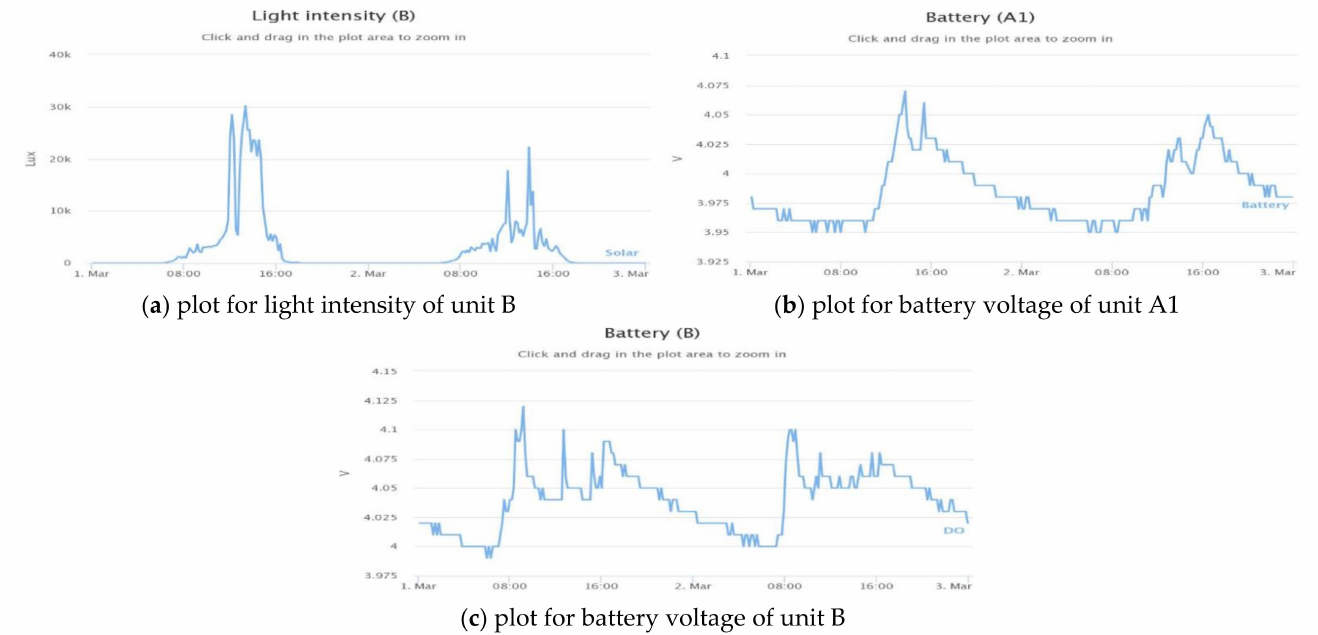
Figure 11. Snapshots of light intensity and battery voltage.